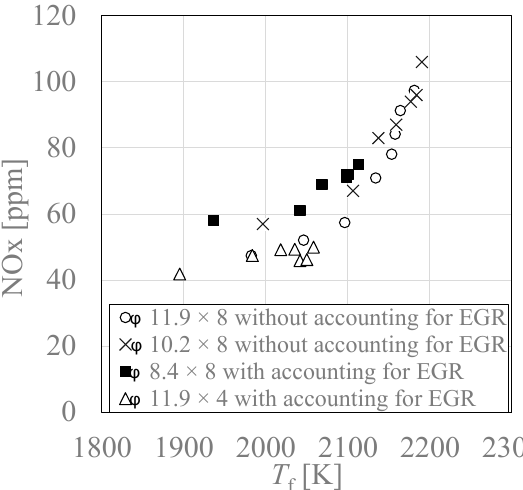
Figure 16. NOx for different T f accounting for EGR at 1273 K. Input = 174 kW. λ = 1.2. P = +15 Pa. E H2 = 0, 50, 80, 85, 90, 95, 100%.